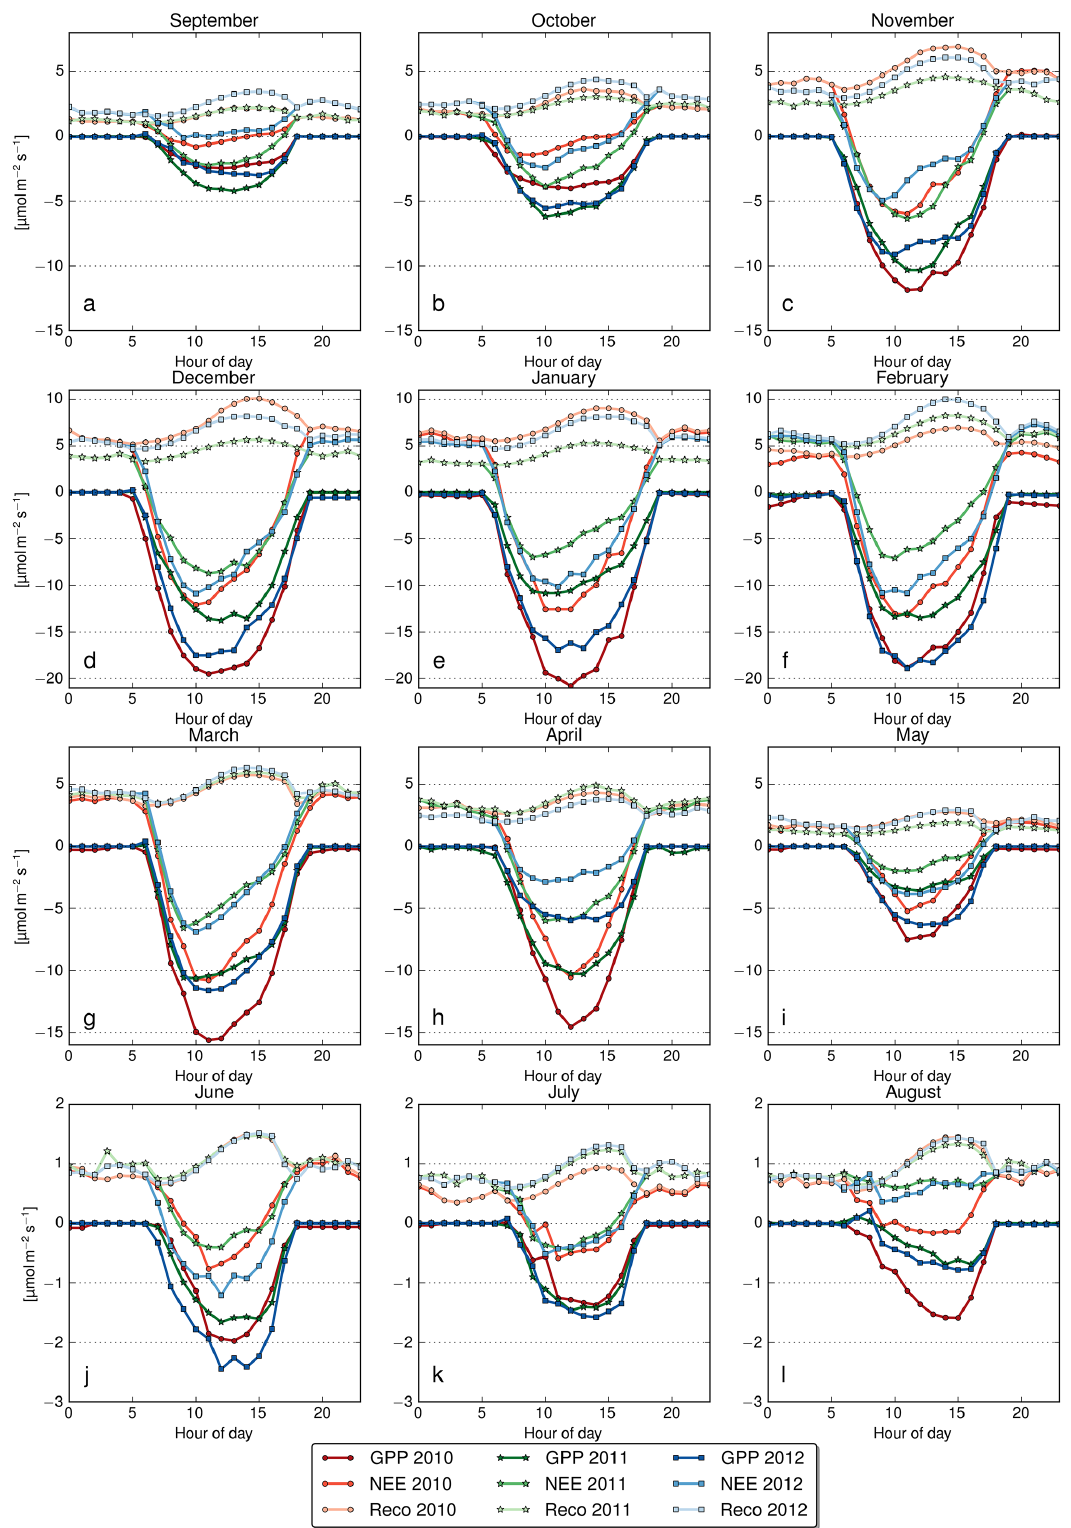
Figure 6. Monthly mean diurnal cycle of GPP, respiration and NEE for each month of the years 2010, 2011 and